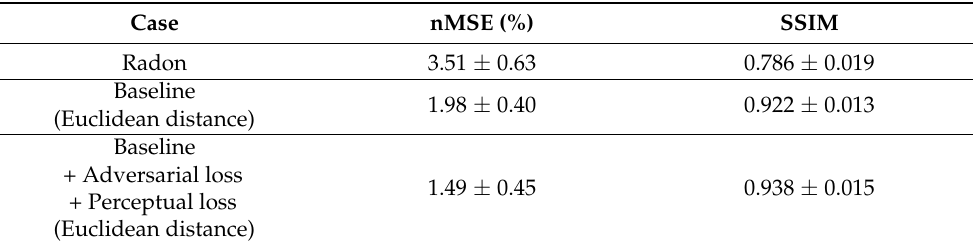
Table 1. Statistics for the proposed and the inverse Radon transform from 100 view angles of radial k-space data. Test set is 48 images from four